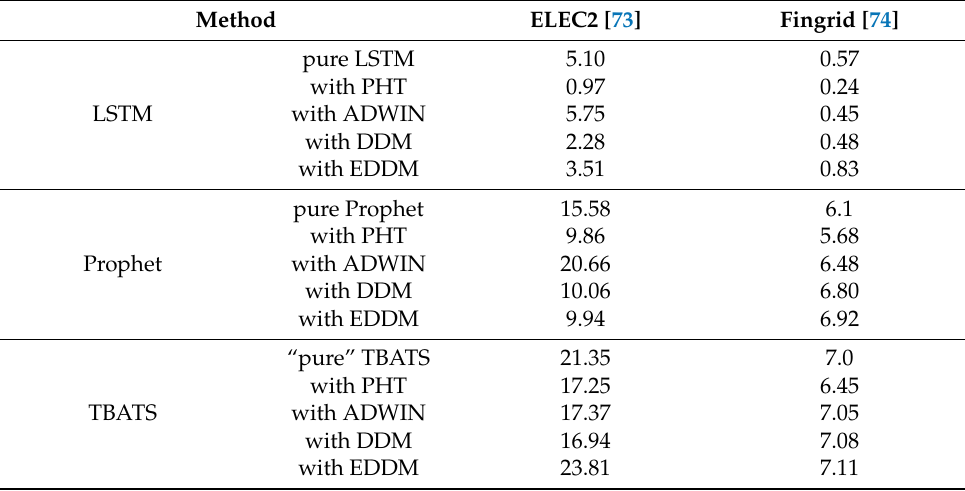
Table 2. Computed mean absolute percentage error (MAPE) for time series